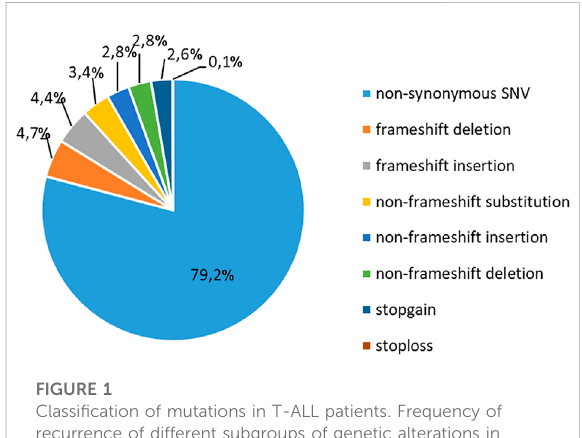
FIGURE 1 Classi fi cation of mutations in T-ALL patients. Frequency of recurrence of different subgroups of genetic alterations in 37 pediatric T-ALL samples. SNV: single-nucleotide